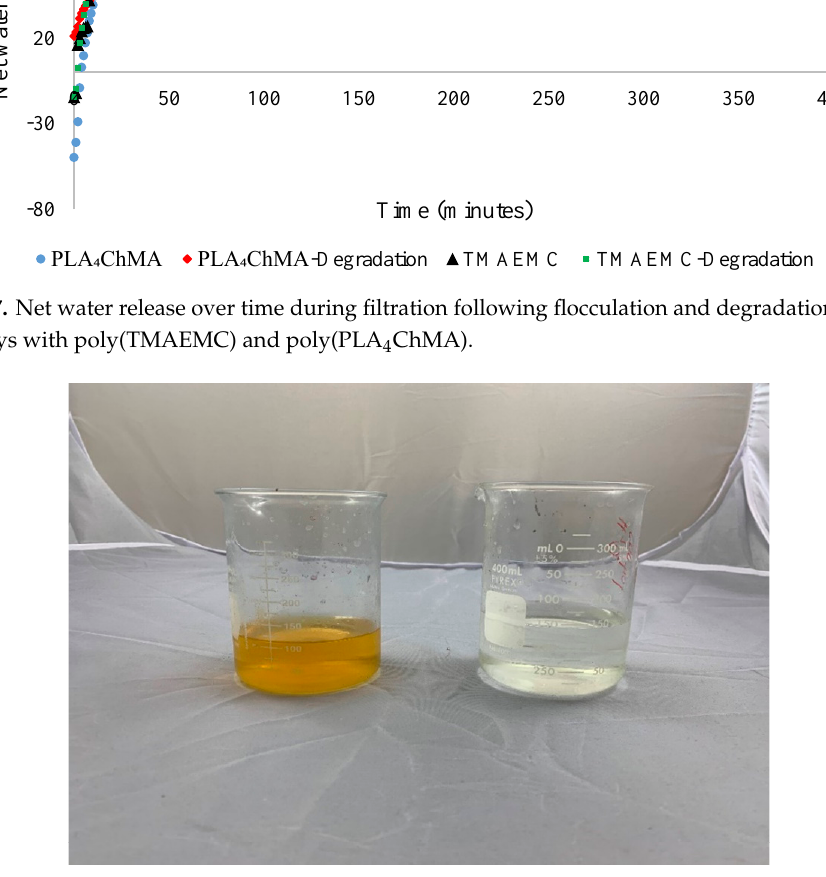
Figure 8. Comparison of water released following filtration after treatments with poly(PLA 4 ChMA) ( left ) and poly(TMAEMC) ( right ).